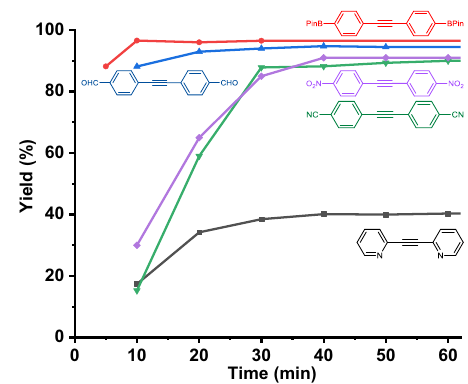
Fig. 4 Kinetic studies of the alkyne metathesis using VIII-d catalyst. Various substrates were tested. The reaction was monitored using 1 H NMR spectroscopy and the yield was estimated based on the integration of the proton signals. Conditions: 0.1 mmol substrate, 150 mg 5 Å